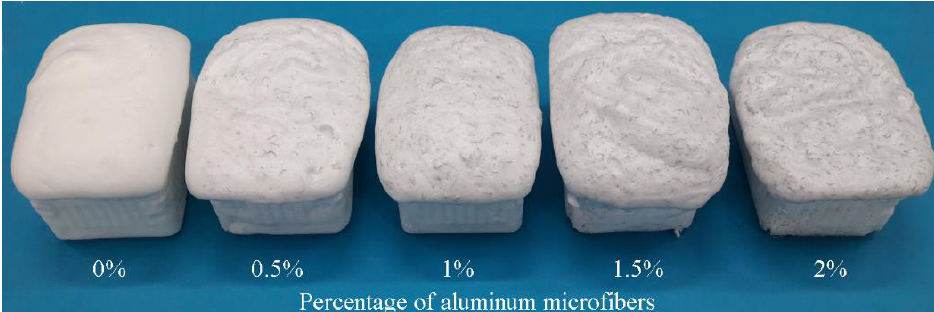
Figure 2. Semi-rigid PU foam blocks obtained depending on the percentage of AMs.